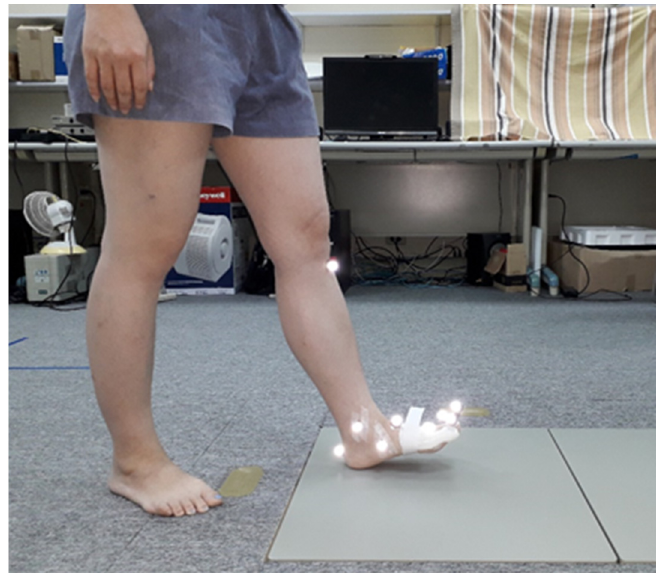
Figure 2. Gait analysis of a patient wearing the 3D-printed orthosis.